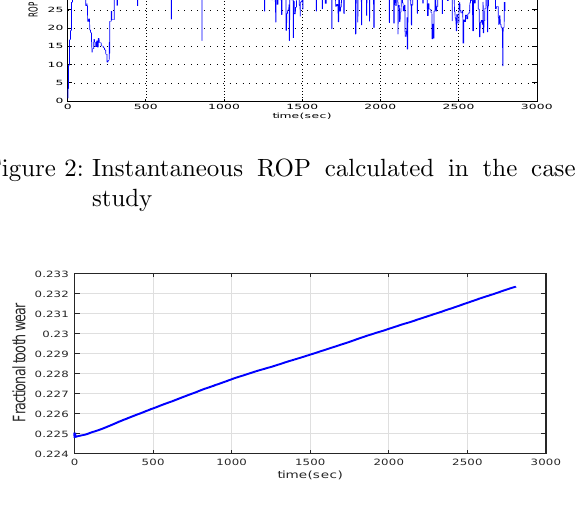
Figure 3: Fractional tooth wear calculated in the case study